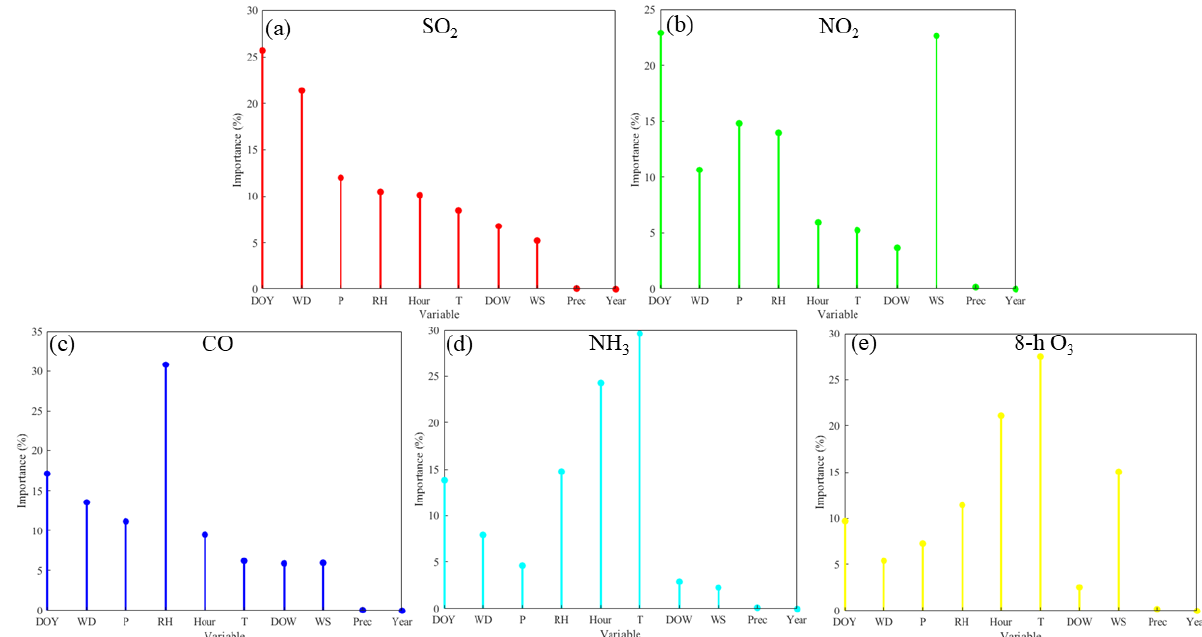
Figure 7. Relative importance of the predictors for the prediction of gaseous pollutants. The match in the figure denotes the variable impor- tance in RF models for various species. DOY, WD, P , RH, Hour, T , DOW, WS, Prec, and Year represent day of year, wind direction, air pressure, relative humidity, hour of the day, air temperature, day of week, wind speed, precipitation, and study year.